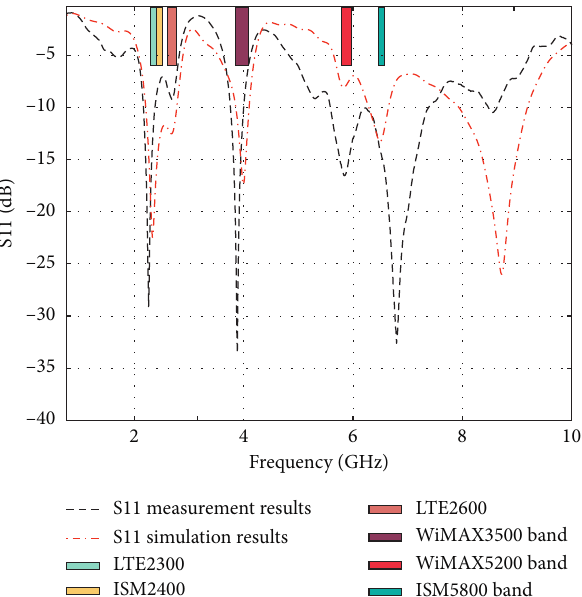
Figure 7: S 11 measurements results compared to simulations.